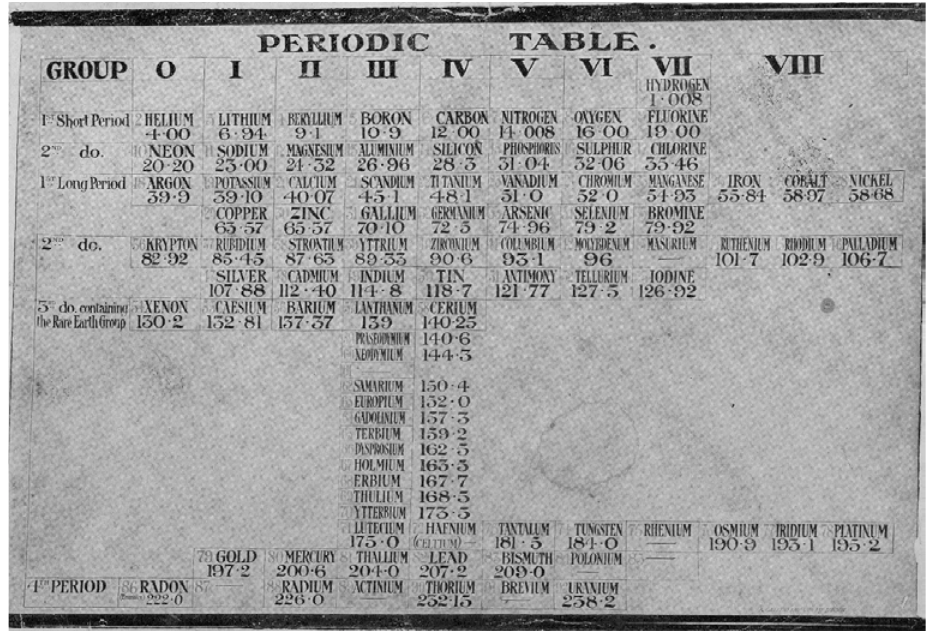
Figure 7. A later periodic table found at the University of St Andrews dating from the 1920’s or 1930’s. Courtesy of the University of St Andrews Library: